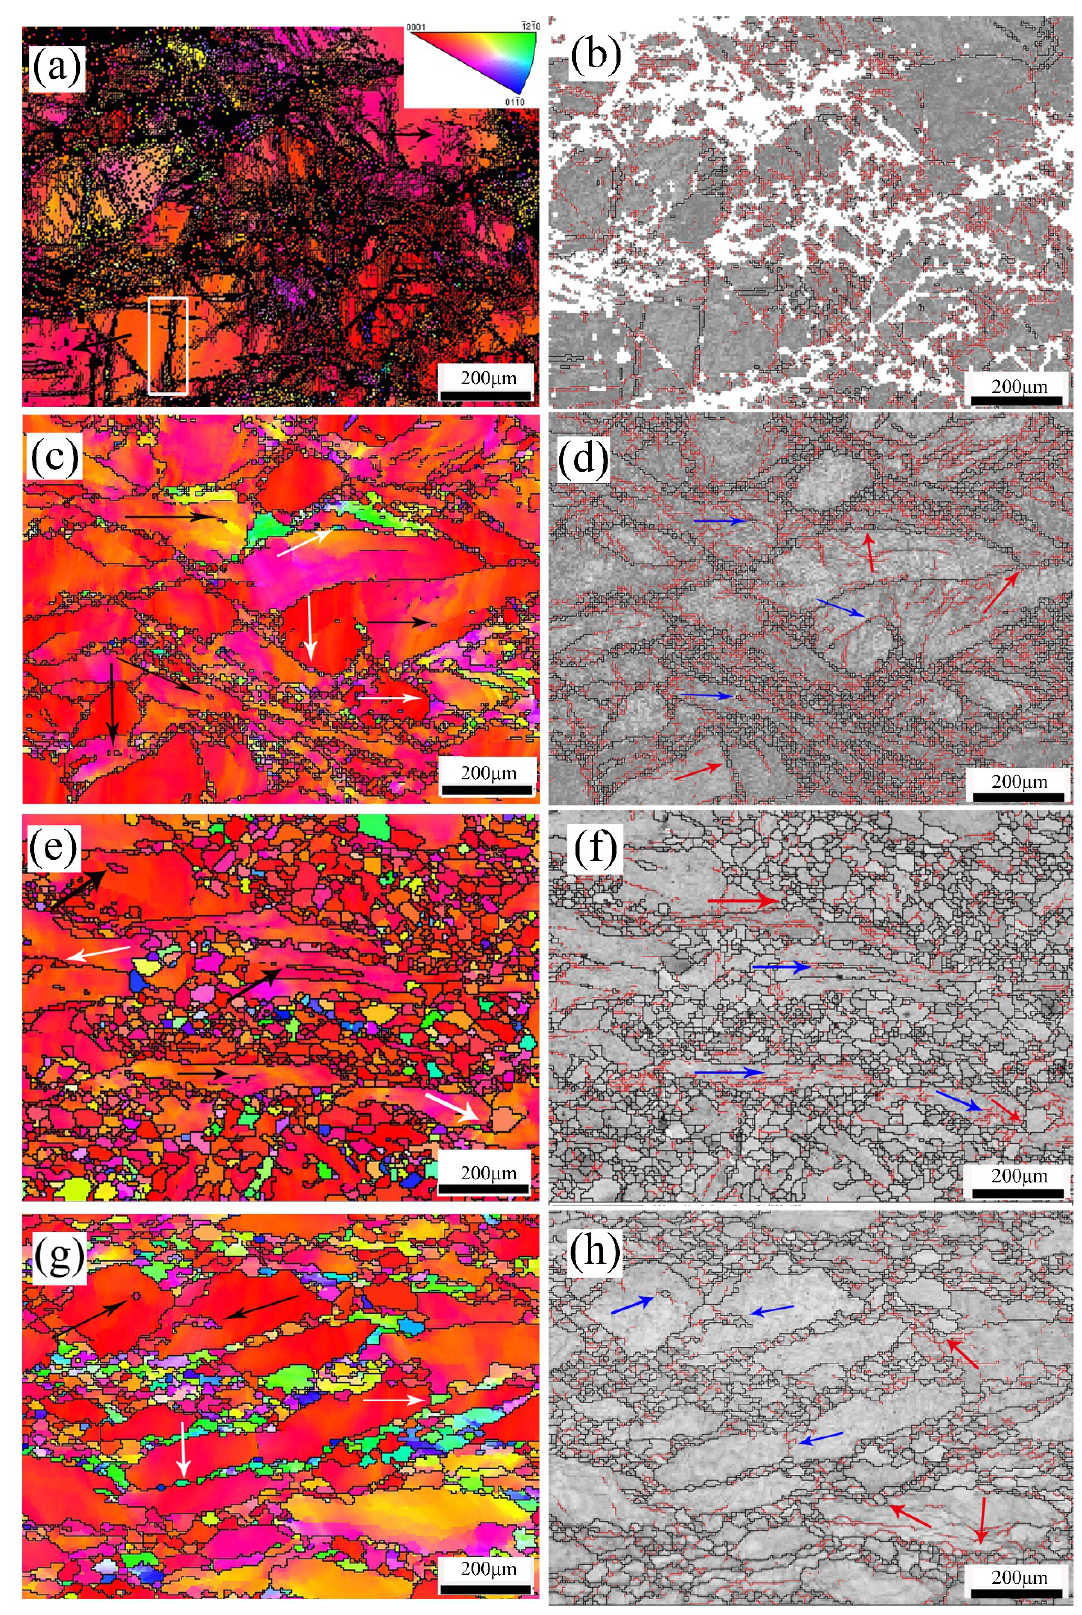
Figure 12. Inverse pole figure maps ( a , c , e , g ) and grain boundary maps ( b , d , f , h ) of the LA11 alloy under various deforma- tions: ( a , b ) 200 ◦ C/0.01 s − 1 , ( c , d ) 300 ◦ C/0.01 s − 1 , ( e , f ) 400 ◦ C/0.01 s − 1 and ( g , h ) 400 ◦ C/0.1 s − 1